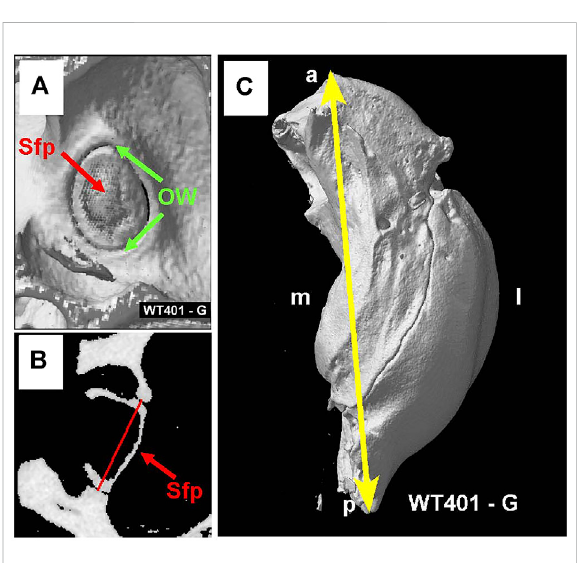
FIGURE 9 (A) MicroCT view showing interior surface of the stapes footplate (Sfp, red arrow) within oval window (OW, green arrows). (B) MicroCT cross section showing maximum width (red line) of oval window aperture. (C) The overall length of the tympanic cavity was measured in all samples as illustrated for a WT mouse (yellow line). Sample orientation: anterior (a), posterior ( p ), medial (m) and lateral